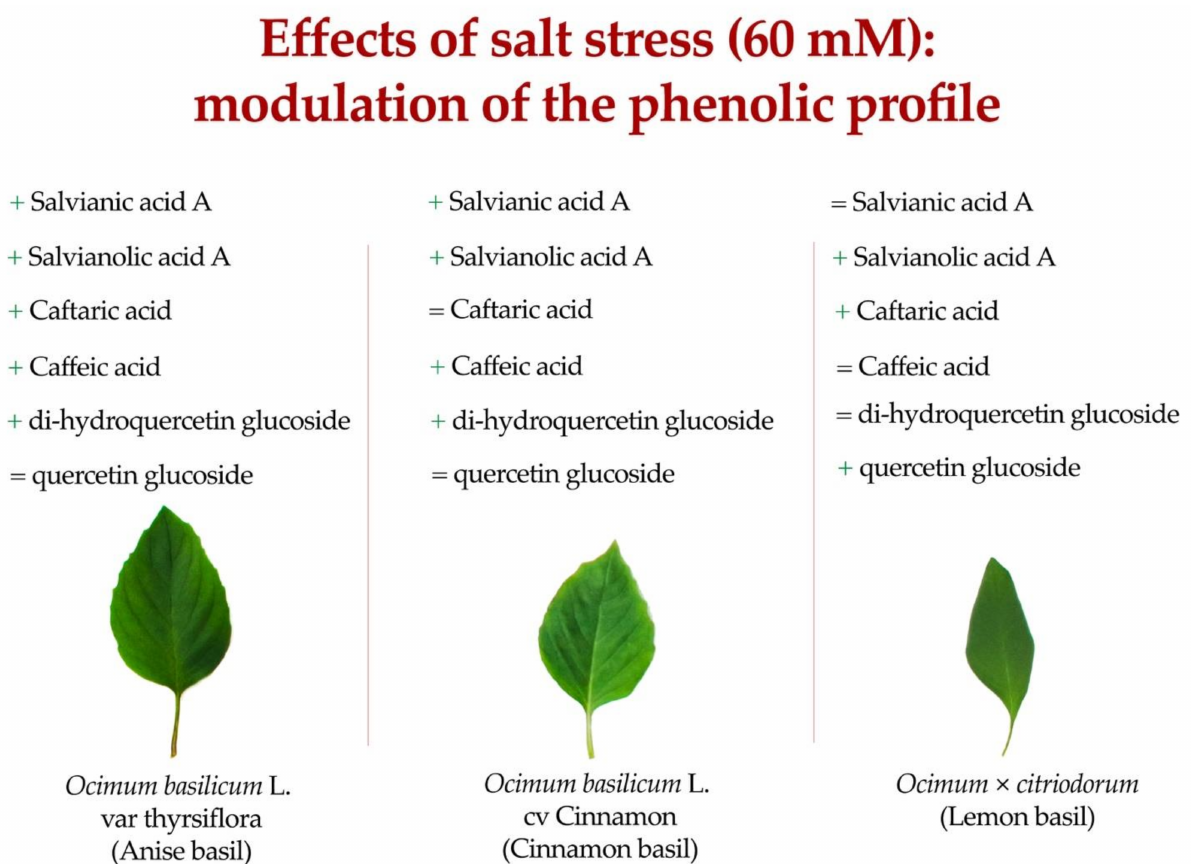
Figure 8. Effect of salt stress on representative phenolic compound of ‘Anise’, ‘Cinnamon’, and ‘Lemon’